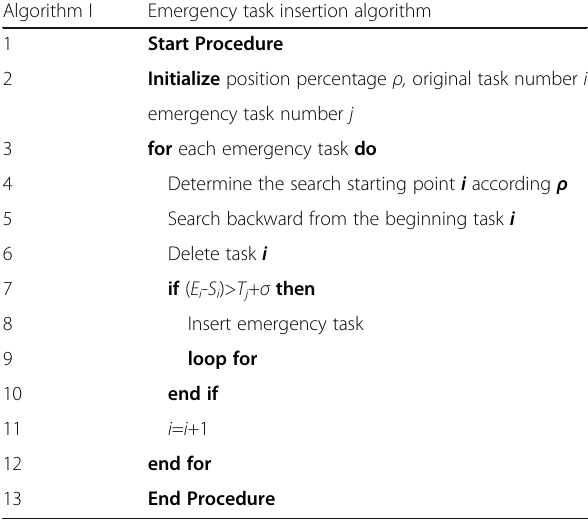
Table 1 Emergency task insertion algorithm Algorithm